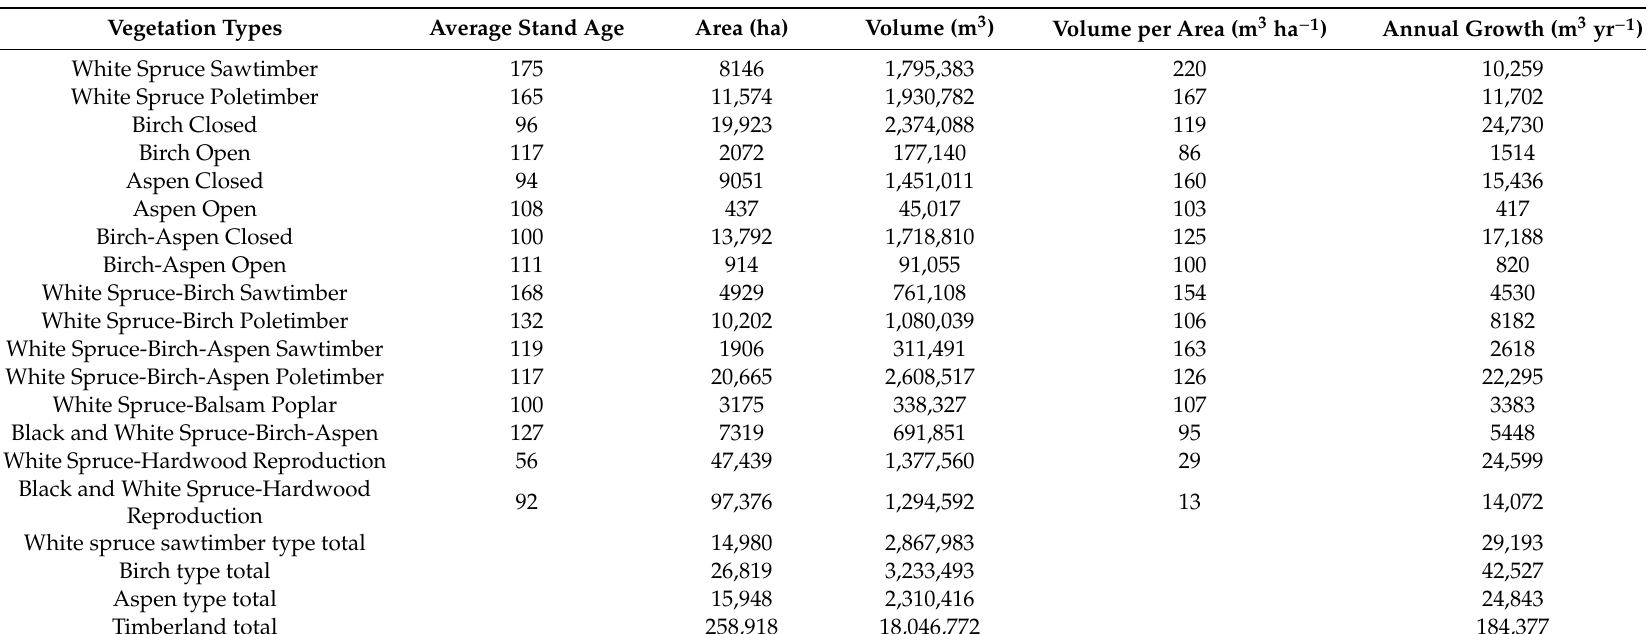
Table 4. Average stand age, area, timber volume, volume per area, average annual growth, and annual growth of each timberland vegetation type on state forest lands (Delta management